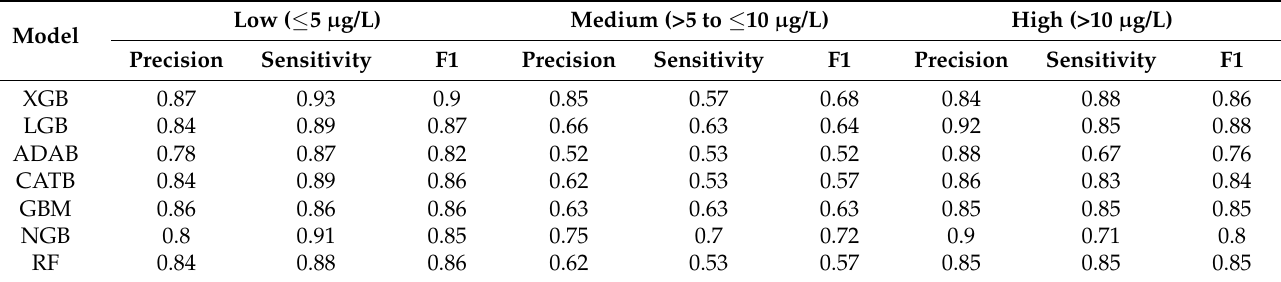
Table 6. Single-class performance of developed models on testing